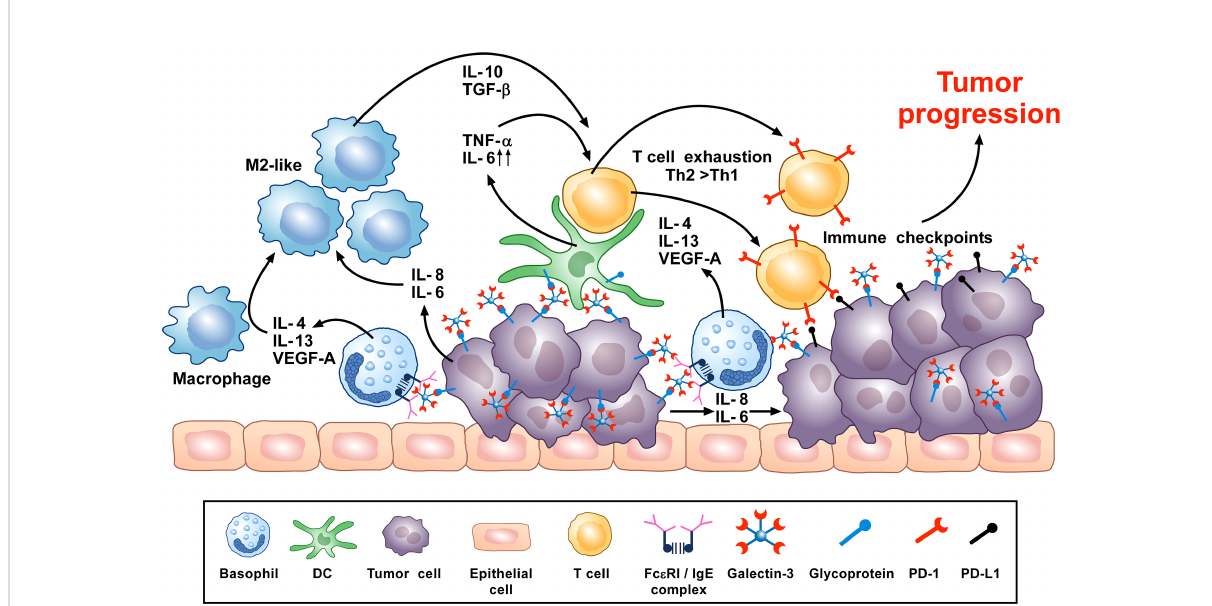
FIGURE 3 Theoretical representation of how basophils can promote tumor progression. Galectin-3 (Gal-3) is a lectin highly expressed by many types of cancer cells, frequently manifesting as a marker of poor prognosis with capacity to mediate immunosuppression within the tumor microenvironment (TME) (266). Recent in vitro studies show that Gal-3, expressed by the A549 adenocarcinoma cell line (or EC-Gal-3), has the capacity to activate basophils to secrete copious amounts of IL-4/IL-13 (16, 223). Both cytokines are known to promote M2-like macrophages, which are major players in the TME (227, 263 – 265). IL-4-producing basophils have been identi fi ed in the TME of human pancreatic cancer, with mouse models indicating that this IL-4 promotes a Th2>Th1 response that is more conducive to tumorigenesis (80). Additionally, basophils are long known to secrete VEGF-A (64) that promotes angiogenesis. Other studies show that basophils can induce IL-6/IL-8 secretion from cell lines through a mechanism requiring cell-to-cell contact (283) (JTS, unpublished). This tumor cell-derived IL-6/IL-8 is implicated in playing a critical role in metastasis formation (284). Likewise, dendritic cells and monocytes activated by EC-Gal-3 are shown to produce high levels of TNF- a /IL-6 in vitro (285). Chronic production of these cytokines, when combined with M2 cell-derived IL-10/TGF- b , are implicated in promoting T-cell exhaustion by up-regulating checkpoint inhibitors (e.g., PD-1) that interact with tumor cell-associated markers (PD-L1) to suppress cytotoxic T cell activity (286). V-domain immunoglobulin suppressor of T-cell activation (VISTA) is another immune checkpoint receptor which plays a role in cancer progression (287, 288) and regulates allergen-speci fi c Th2-mediated immune responses (289). Overall, it is proposed that the combined actions of these dysregulated innate immune responses synergize to promote